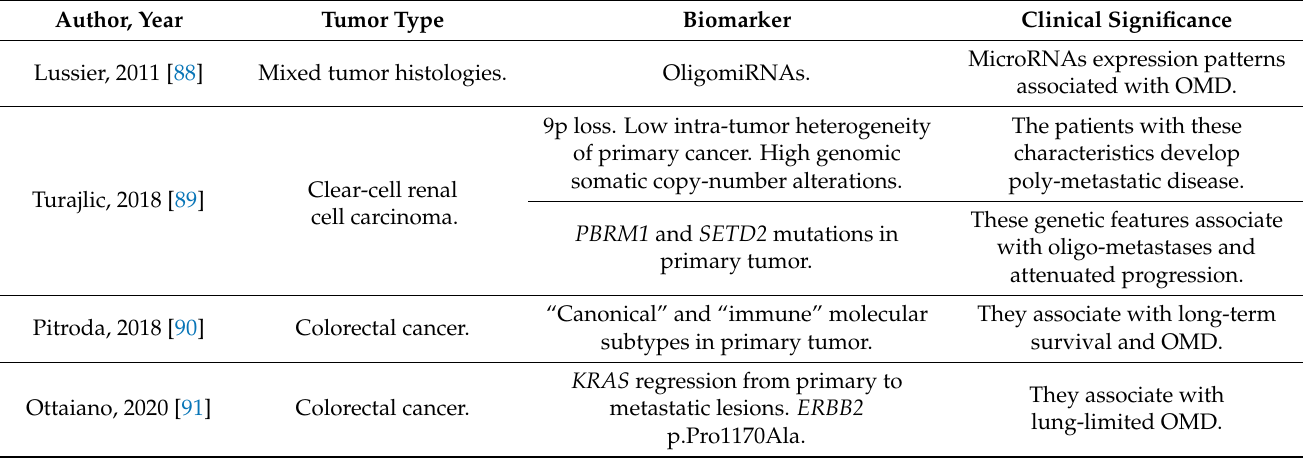
Table 3. Biomarkers identifying the oligo-metastatic